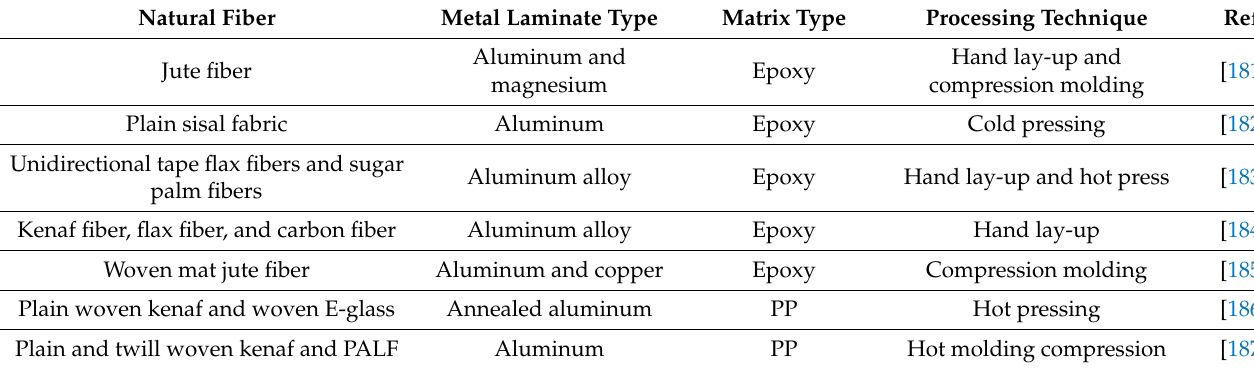
Table 6. Studies on hybrid natural fiber/metal-reinforced polymer